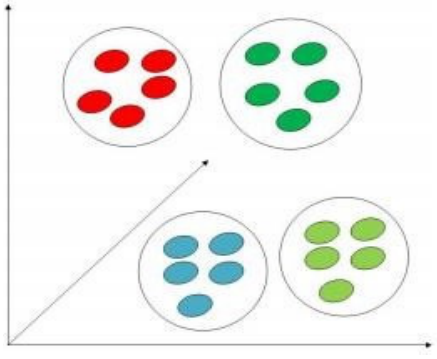
Figure 2. The creation of ‘Vocabularies’ in ‘BoW’ model.